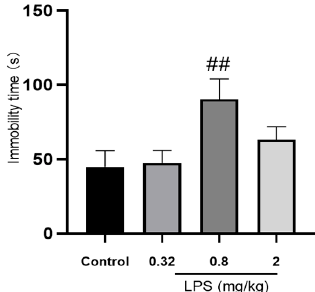
Figure 1 . Effects of different doses of LPS (i.p.) on the immobility time of mice in the tail suspension test (TST). The graph is plotted as mean ± SEM ( n = 12 for each group). Data were analyzed by the Mann–Whitney U test. ## p < 0.01 compared to the control group.